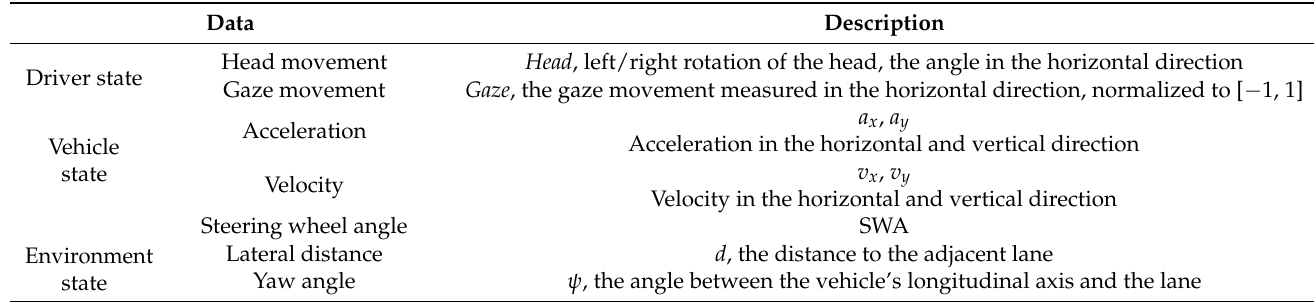
Table 1. Details of monitoring